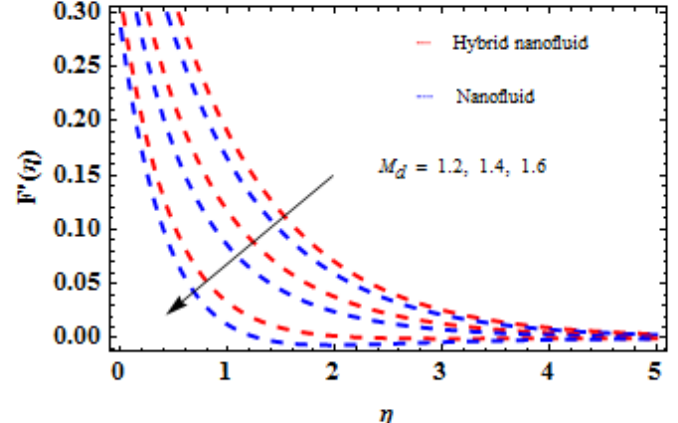
Figure 18. Influence of 𝐵 𝑣 via dust velocity.